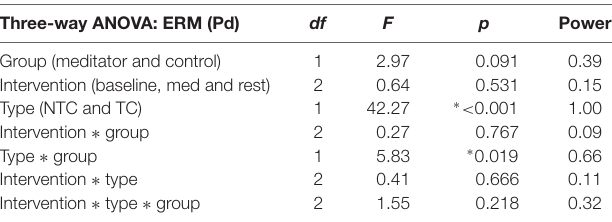
TABLE 4 | Results of ANOVA of ERM (Pd)